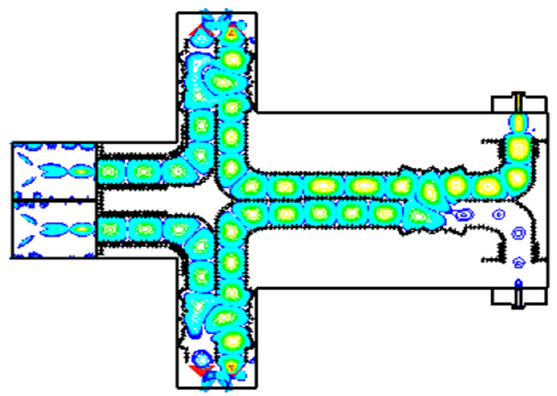
Figure 11. Electric field distribution in SIW beam steering antenna system at 17 GHz when port 1 is excited.